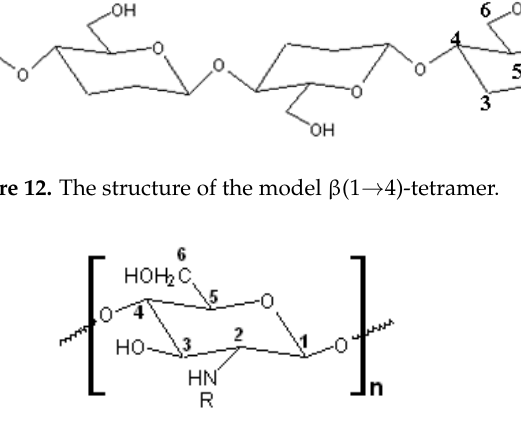
Figure 13. The scheme of the protons in the chitin monomer.